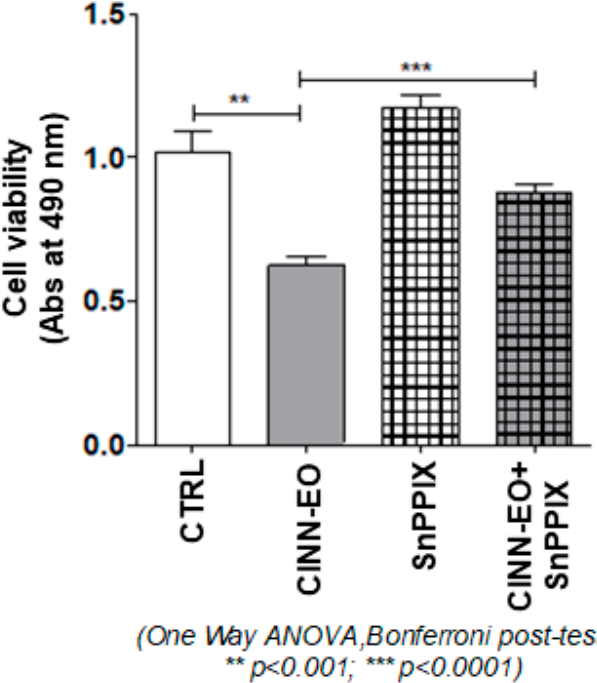
Figure 8. SnPPIX rescues the inhibition of cell proliferation induced by CINN-EO on M14 cells. Results of an MTS assay on M14 cells exposed to CINN-EO alone or in combination with the HMOX1 inhibitor SnPPIX (5 µM) for 24 h. The values are expressed as the mean ± SD from three independent experiments.